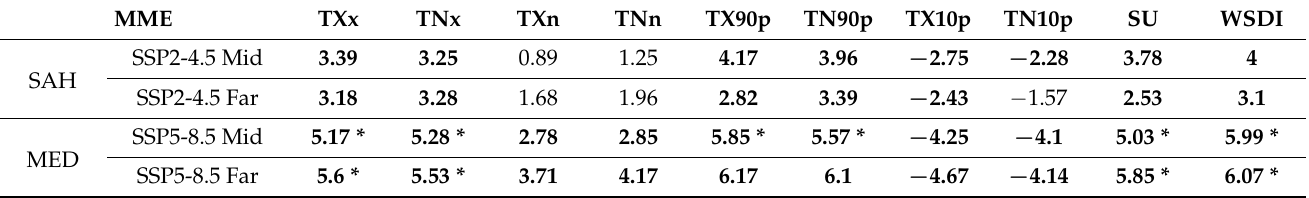
Figure 12. Same as Figure 11, but for the far-future (2071–2100). Table 3. Modified Mann–Kendall Z values for significance test of various temperature indices during mid-future (2041–2070) and far-future (2071–2100) under SSP2-4.5 and SSP5-8.5 over SAH and MED region. The bold denotes significant trends at a 95% confidence level. The asterisk (*) denotes significant at a 99% confidence